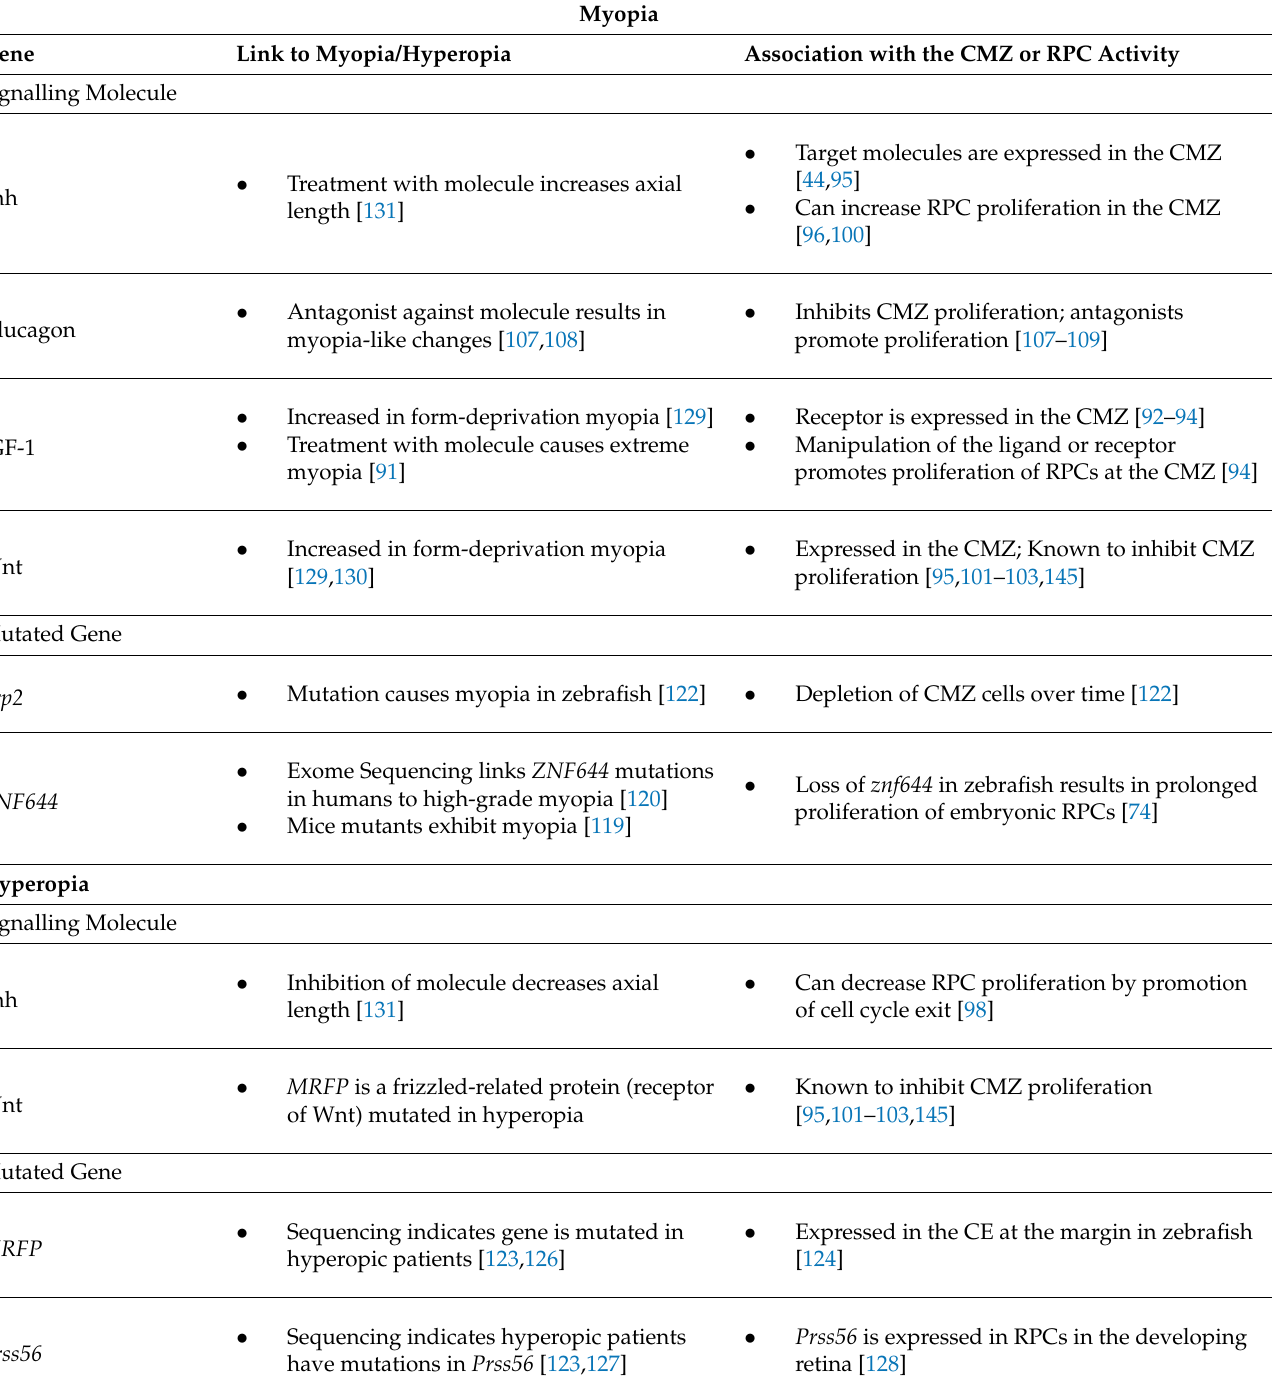
Table 1. Known genes and signalling pathways linked to CMZ/RPC regulation that also result in dystrophic eye growth conditions, myopia or